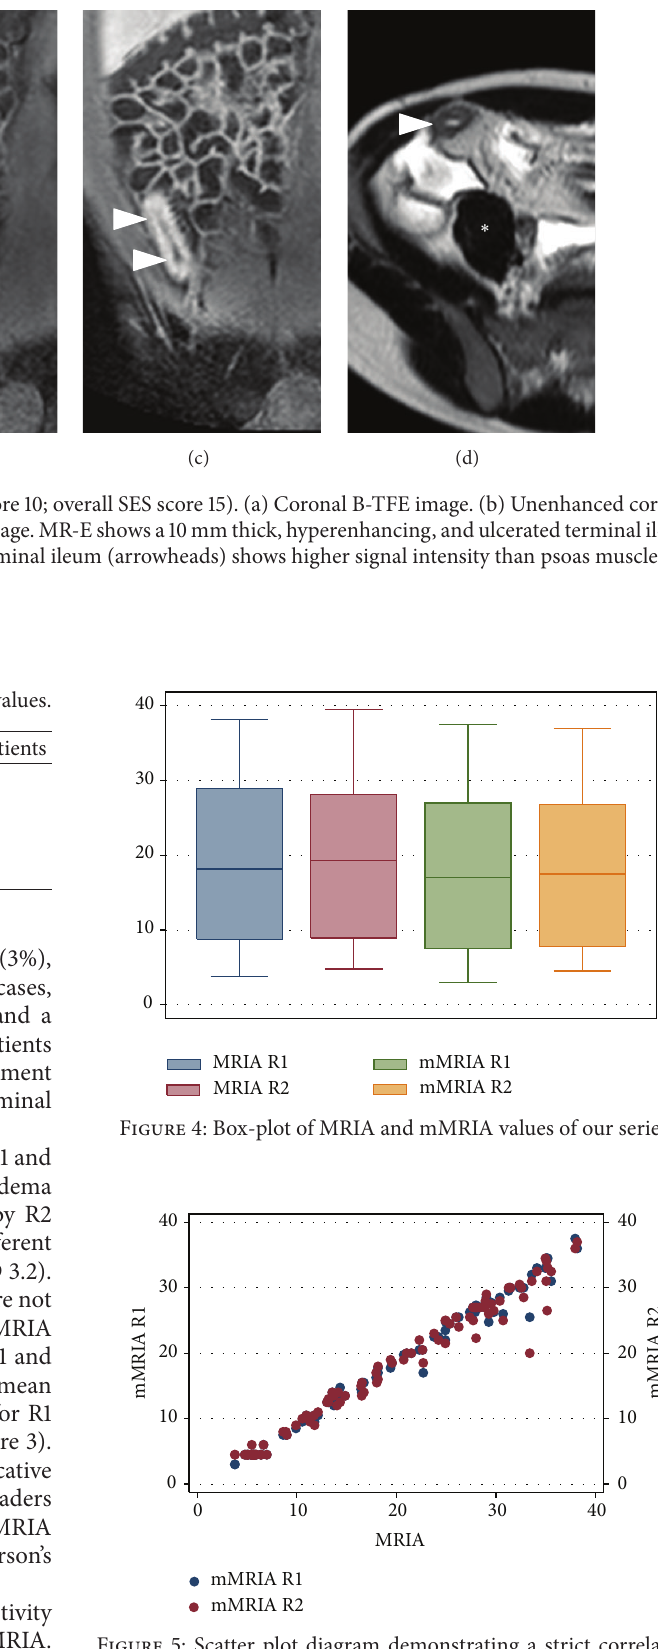
Figure 5: Scatter plot diagram demonstrating a strict correlation between MRIA and mMRIA values for both the